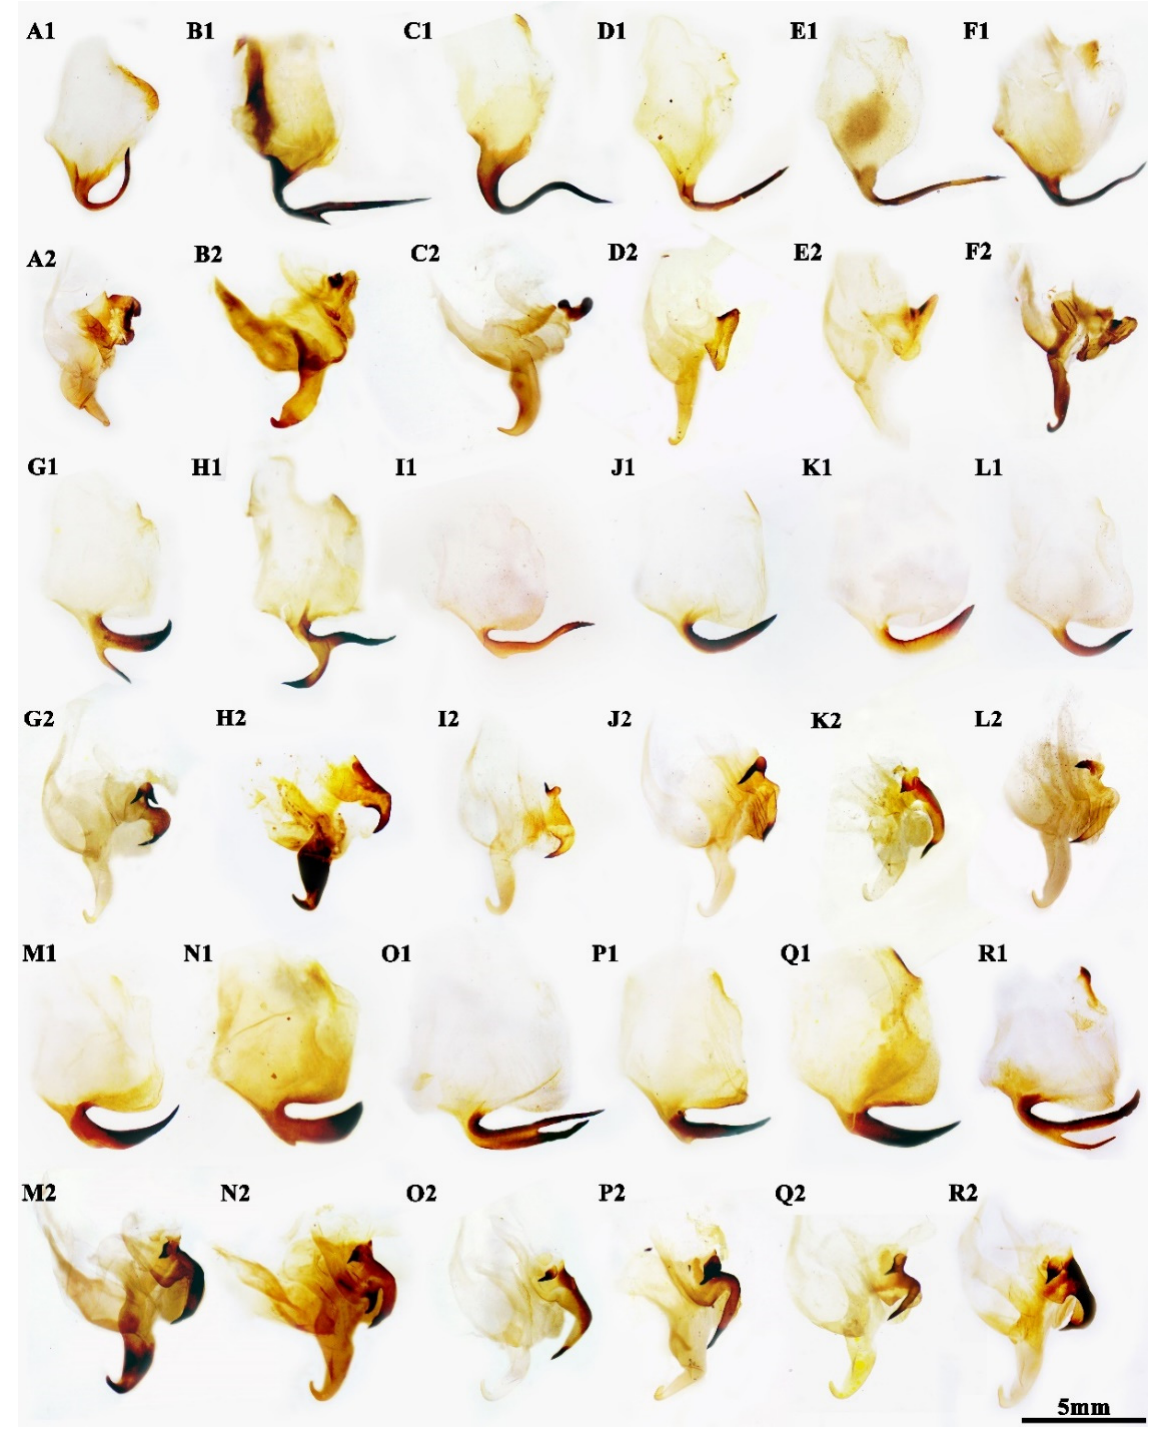
Figure 1. Male genitalia of Hierodula and Rhombodera (( 1 ) ventral phallomere; ( 2 ) left phallomere; Right phallomeres omitted). ( A ) Mekongomantis quinquespinosa . ( B ) Hierodula confusa . ( C ) Hierodula membranacea . ( D ) Hierodula patellifera . ( E ) Rhombomantis longipennis . ( F ) Rhombomantis fusca . ( G ) Hierodula latipennis . ( H ) Rhombodera kirbyi . ( I ) Rhombodera stalii . ( J ) Rhombodera latipronotum . ( K ) Rhombodera valida (Java). ( L ) Rhombodera valida (Yunnan). ( M ) Hierodula jianfenglingensis. ( N ) Rhombodera zhangi . ( O ) Rhombodera megaera . ( P ) Hierodula chinensis . ( Q ) Rhombodera longa . ( R ) Rhombodera hyalina sp. nov.